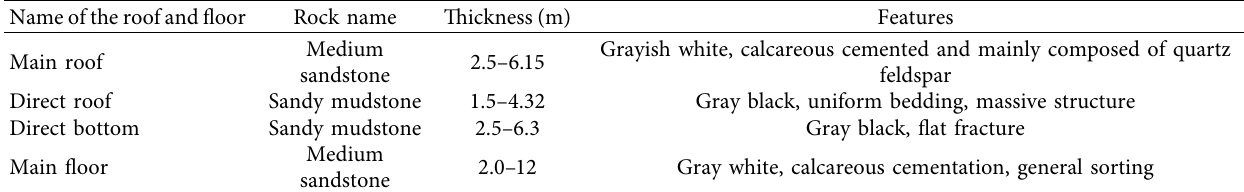
Table 1: Rock property characteristics of coal seam roof and floor.